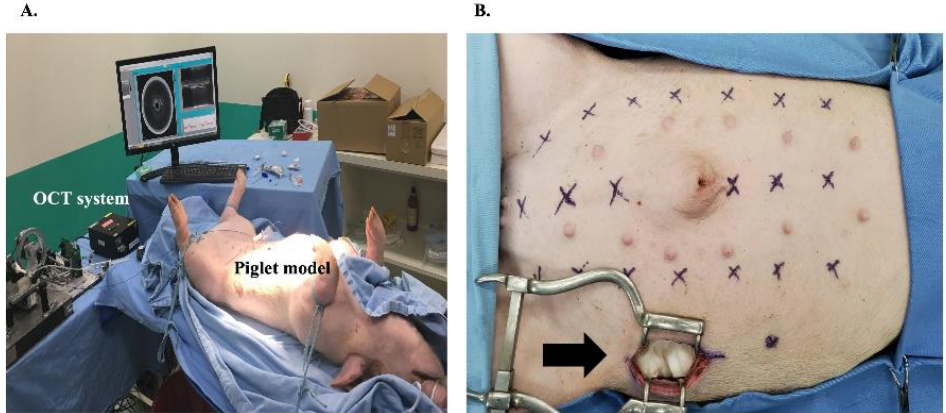
Figure 3. ( A ) Photograph of our SSOCT system with the Veress needle probe and piglet model. ( B ) The designated puncture sites on the piglet abdominal wall. A 5 cm full-thickness abdominal wall incision was created at the lateral abdominal wall to visualize needle placement after the puncture (arrow).